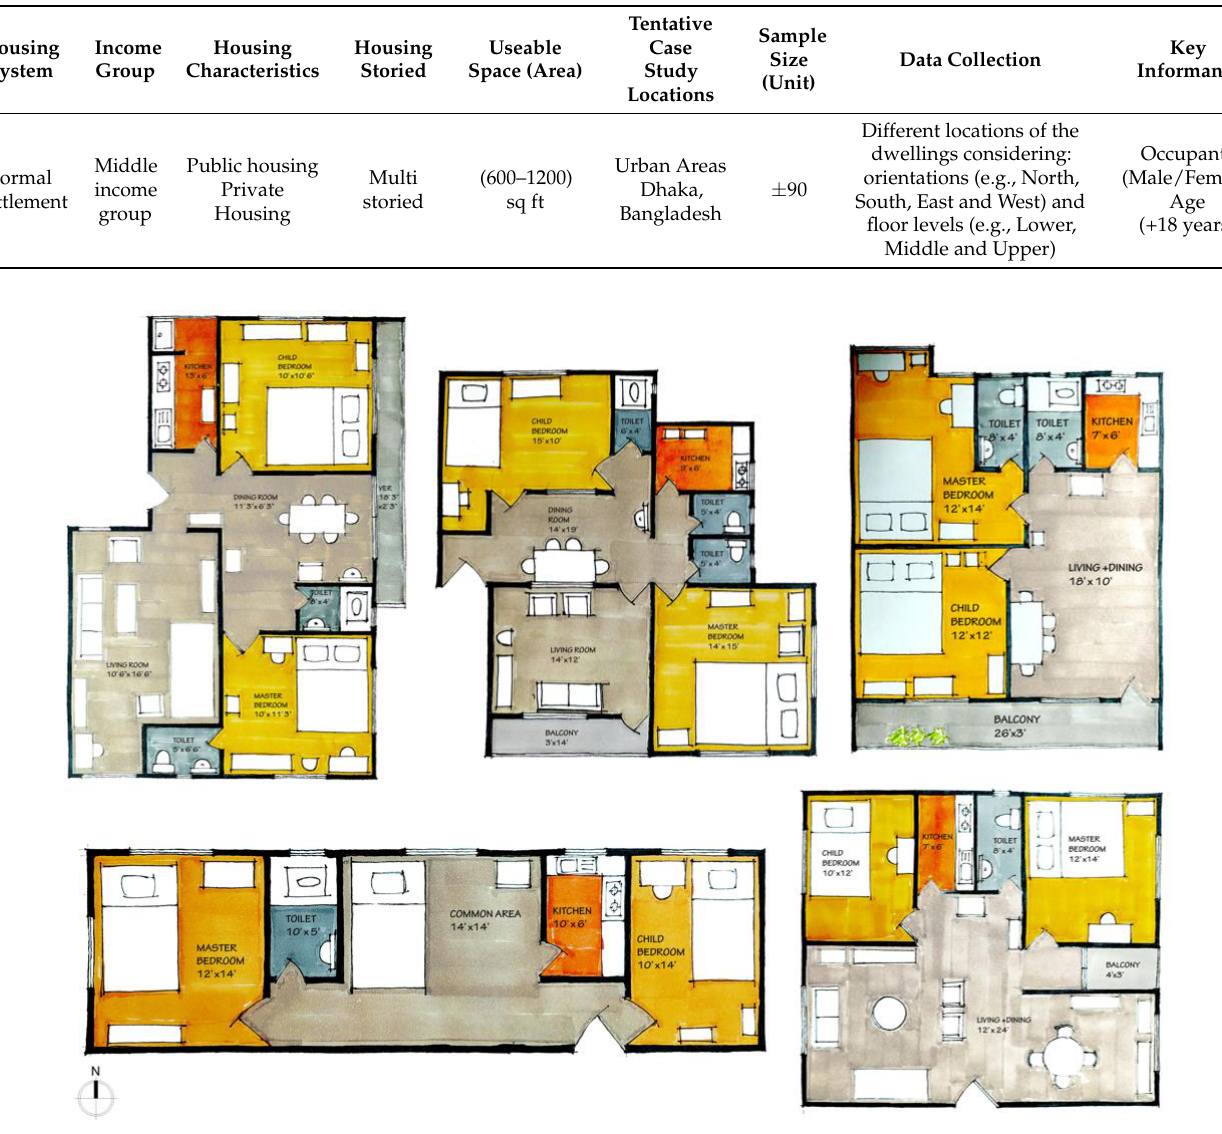
Figure 1. Example of compact domestic living scenarios in Dhaka, Bangladesh. (Source: illustrated from the filed study).